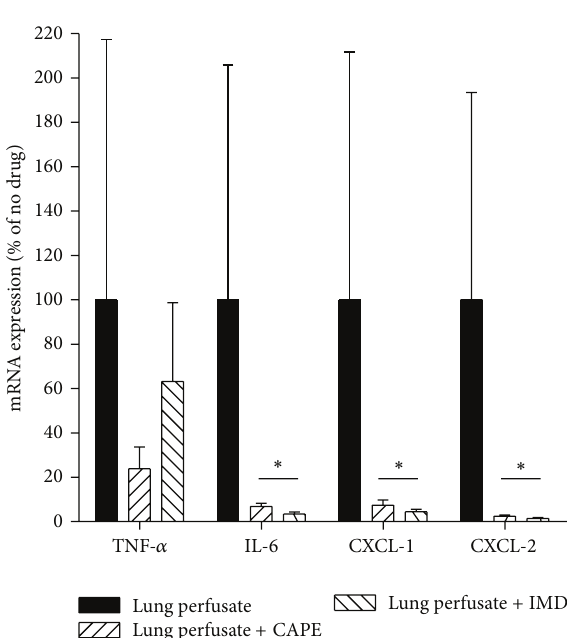
Figure 6: Quantitative PCR for TNF- 𝛼 , IL-6, CXCL-1, and CXCL-2 in liver tissues extracted from nonventilated (nonvent) and in vivo mechanically ventilated (ventilated) mice. Values represent fold- increase over expression in nonventilated mice. ∗ 𝑃 < 0.05 versus non-ventilated mice ±